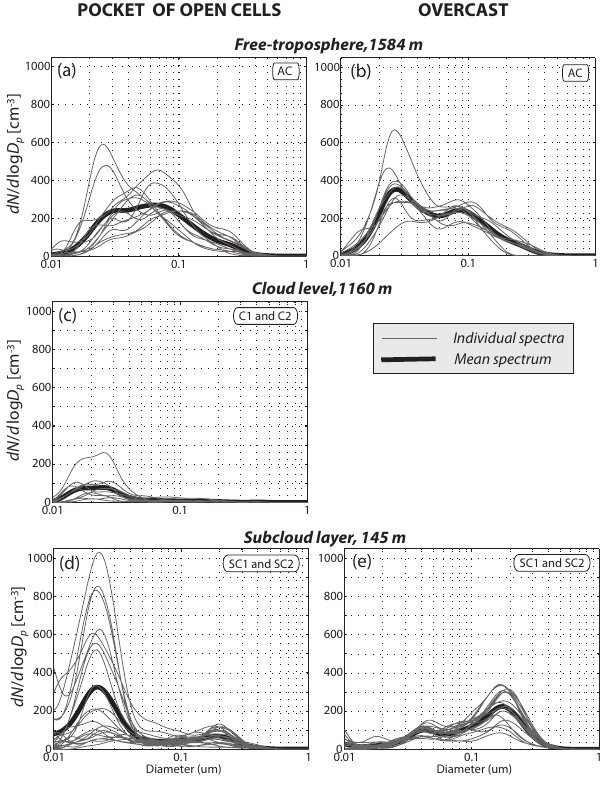
Fig. 15. Aerosol size distributions from RF06 for clear-air samples measured with the University of Hawaii in-cabin sampling system, at different levels in the POC region ( a , c , d for the free-troposphere, cloud level, and subcloud layer, respectively) and for the overcast region ( b and e for the free-troposphere and subcloud layers, respectively). We show both individual spectra (typically taken over 10 s samples) and the mean spectrum for each level/region, to emphasize variability. No data are available from the cloud level in the overcast region since almost the entire leg was cloudy.